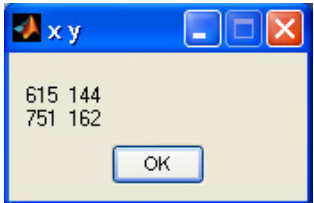
Figure 8: Displaying the Coordinates of the Image